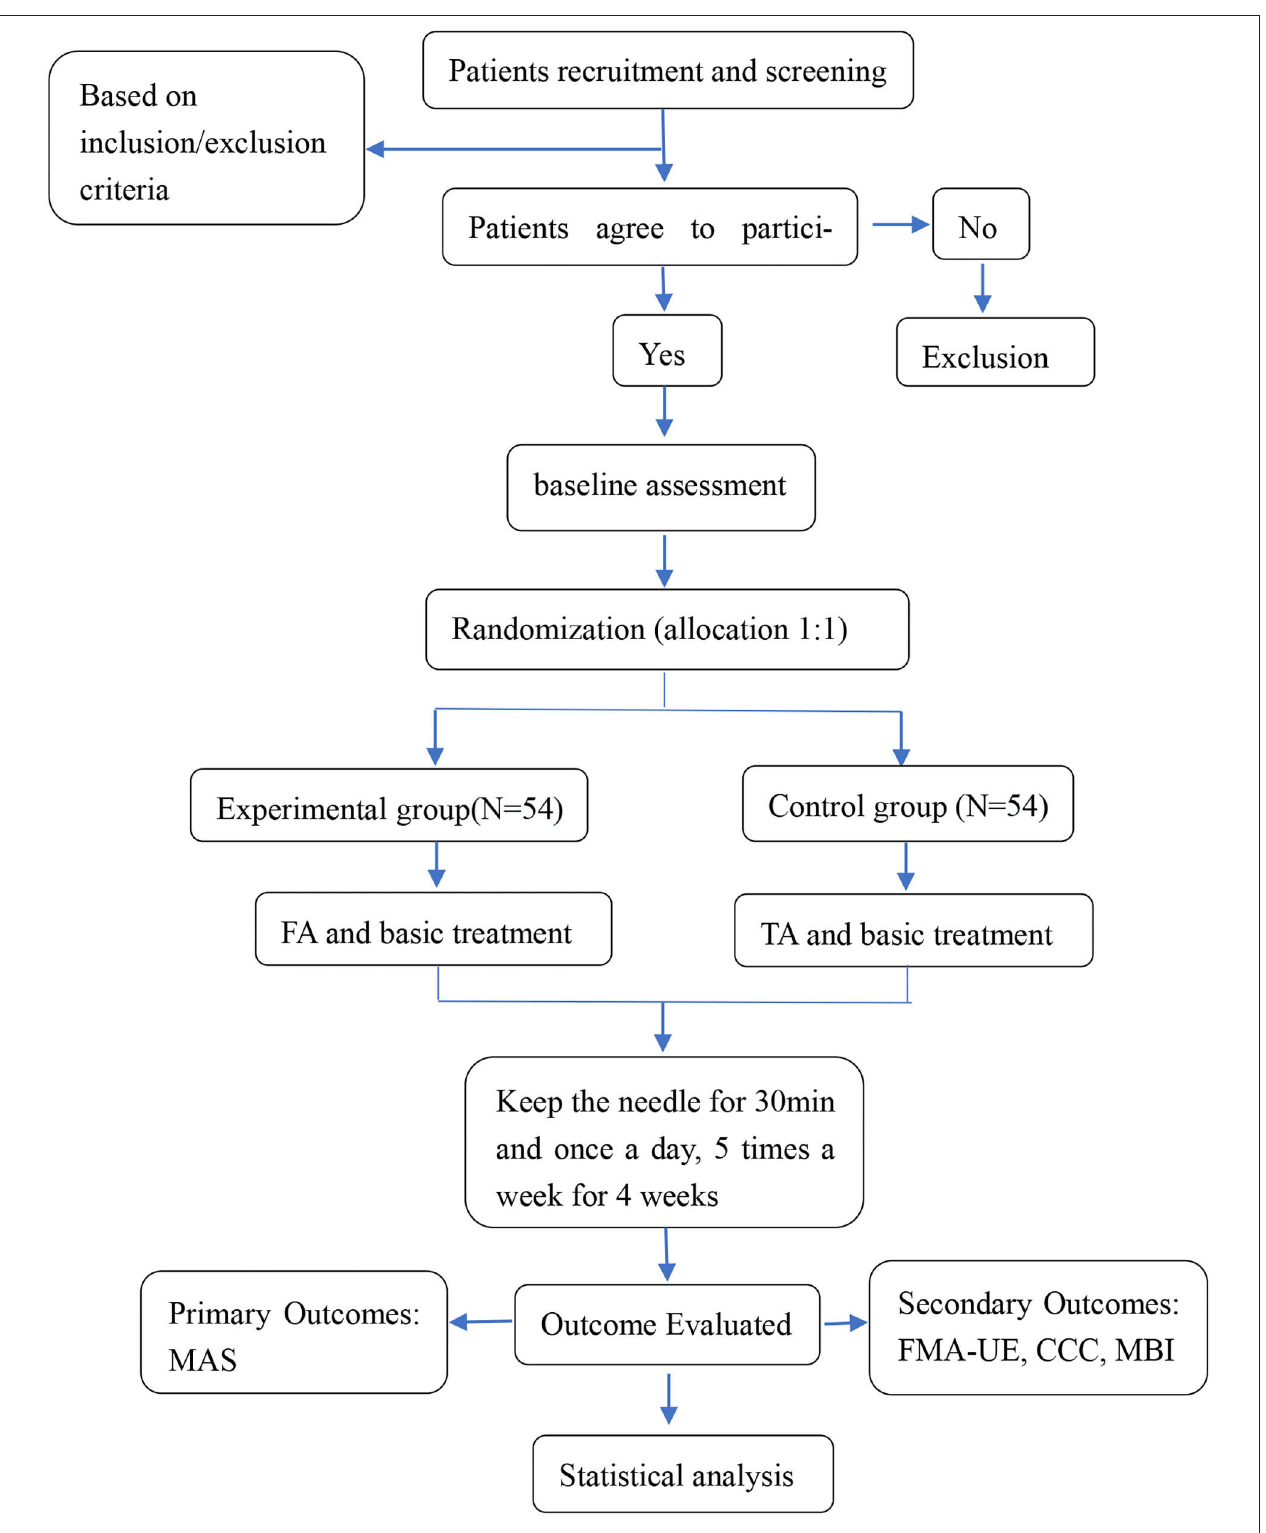
FIGURE 1 | Flowchart of the trial. FA, functional acupuncture; TA, traditional acupuncture; MAS, the Modified Ashworth Scale; FMA-UE, the Fugl-Meyer Assessment for Upper Extremity; CCC, clinical neurological deficit score; MBI, the Modified Barthel Index.